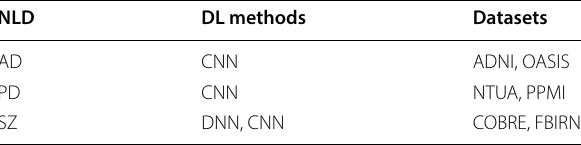
Table 6 Summery of various DL methods and datasets used in detecting NLD